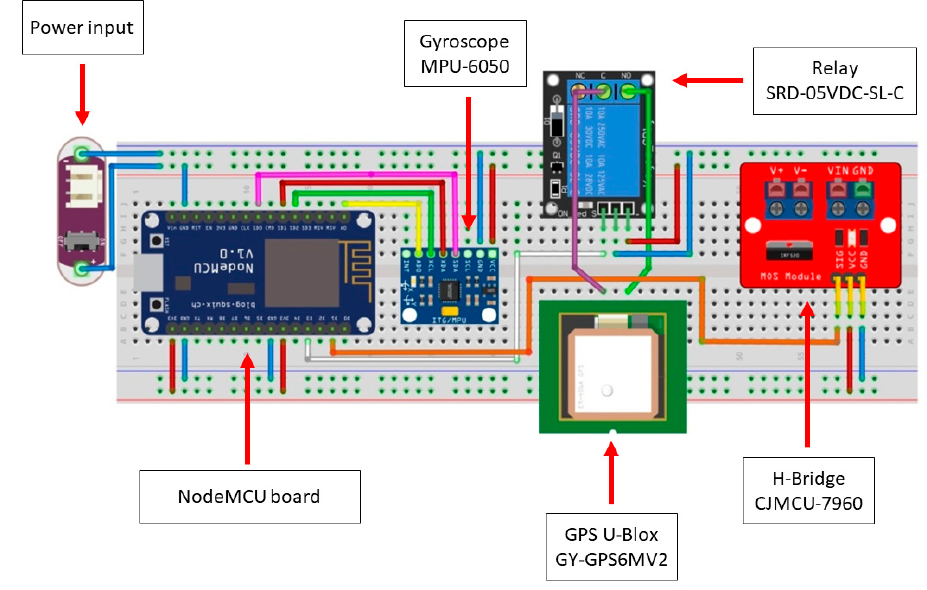
Figure 5. Connections diagram of the control circuit.